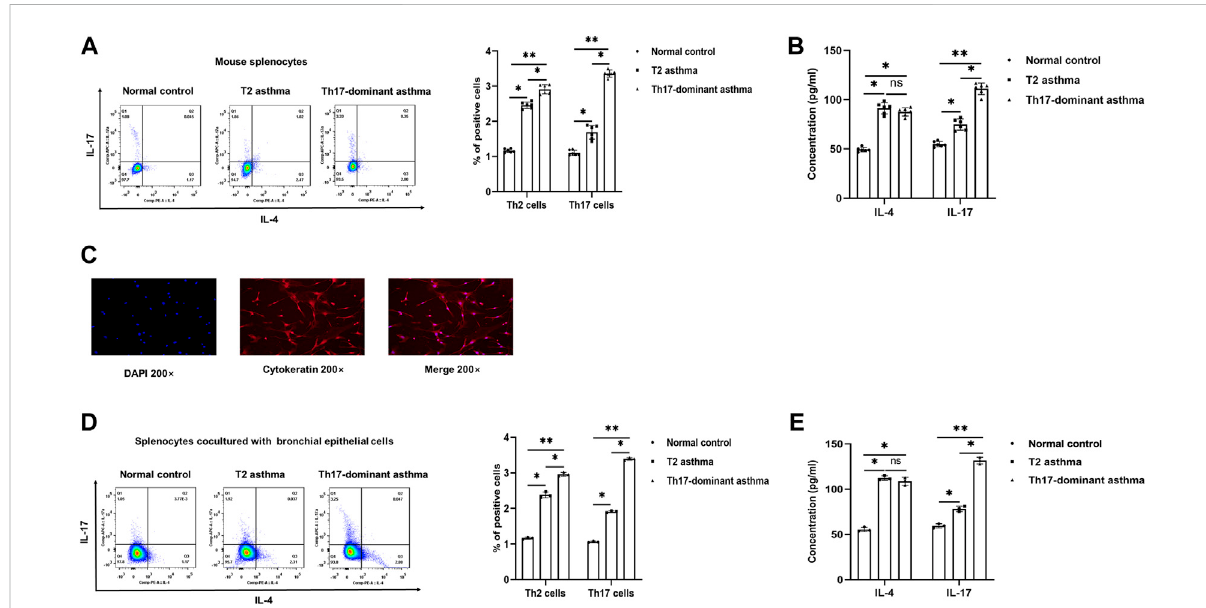
FIGURE 2 Th17-dominantasthma mediatedbyTh17 cells (A) Th17 andTh2cellsweredetectedby fl owcytometry insplenocytes. (B) Serum levelsofIL-17 and IL-4 were detected by ELISA (C) The positive rate of cytokeratin in BECs was determined by immuno fl uorescence. (D and E) After BECs were stimulated with 100 μ g/ml HDM, 100 μ g/ml HDM +100 ng/ml LPS or PBS for 24 h and cocultured with CD4 + T cells for 24 h, the expression of Th2 and Th17 cells was detected by fl ow cytometry, and the levels of IL-17 and IL-4 in the cell supernatant were detected by ELISA. * p < 0.05. ** p <